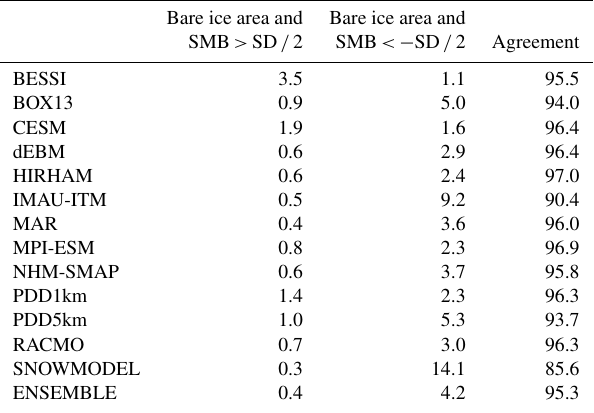
Table 5. Percentage of the main ice sheet area showing the presence of bare ice area detected in MODIS on average over 2000–2012 and where the modelled mean SMB is significantly positive, i.e. where annual SMB is larger than half of the interannual variability (gauged here by the standard deviation). The same is shown for the presence (or lack thereof) of bare ice and where SMB is significantly negative (middle column). The percentage of agreement between modelled ablation zone and bare ice area from MODIS is shown in the right column. Bare ice area and Bare ice area and SMB > SD / 2 SMB < − SD / 2 Agreement BESSI 3.5 1.1 95.5 BOX13